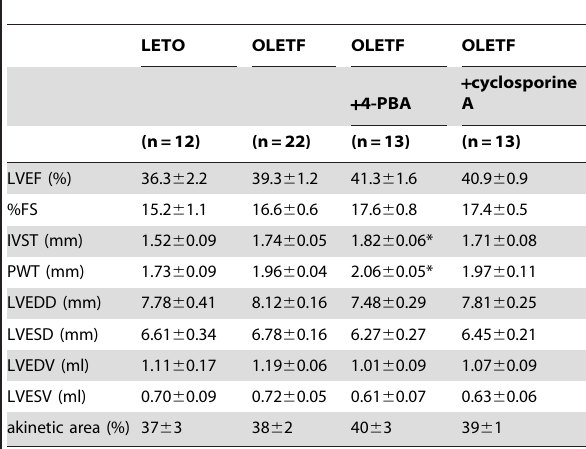
Table 4. Echocardiographic data at 1 hr after coronary ligation.